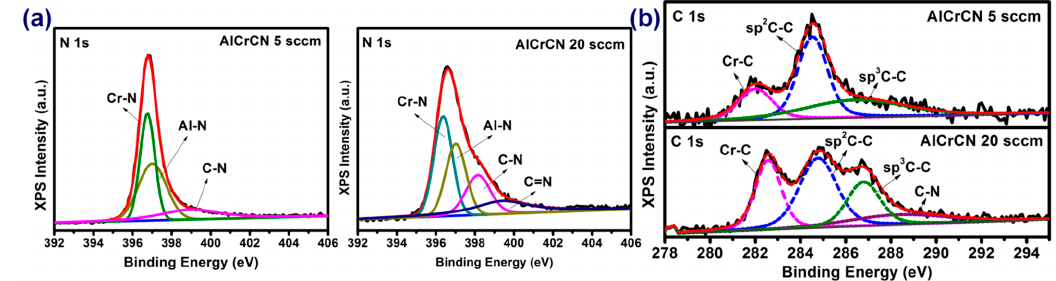
Figure 2. XPS spectra of AlCrCN film after deconvolution: ( a ) N 1s and ( b ) C 1s. Table 1. Area fractions of various bonds of AlCrCN films based on N 1s and C 1s XPS results.